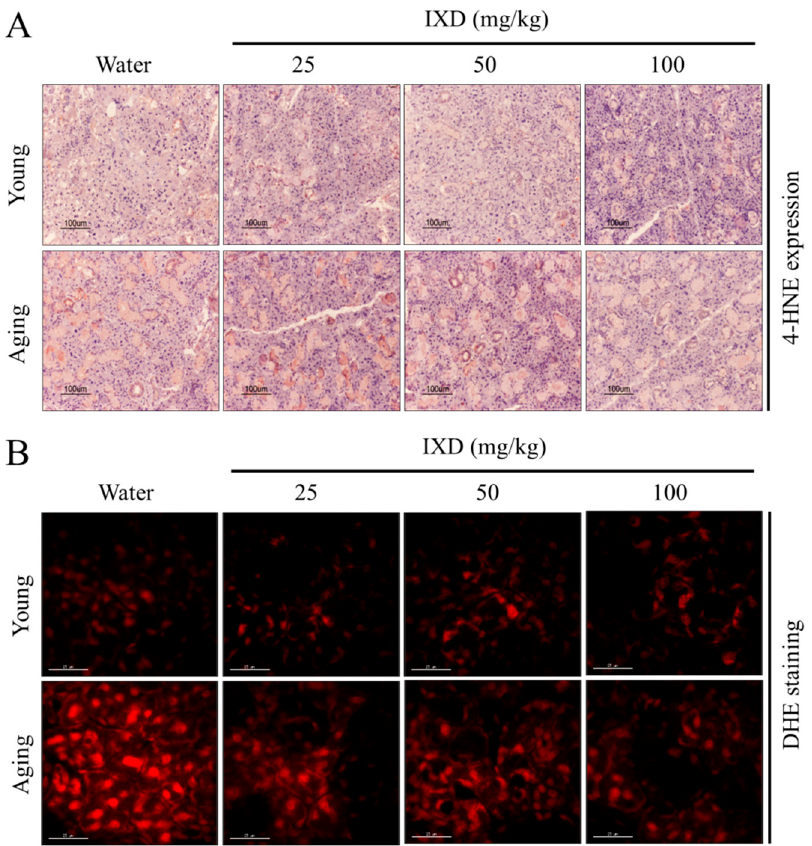
Figure 6. Aging-induced free radical generation was attenuated by IXD extracts. ( A ) Immunohistochemistry data revealing 4-HNE expression in the submandibular glands of the indicated groups. Magnification: 200×, Scale bar: 100 µm. ( B ) Dihydroethidium (DHE) fluorescent staining indicating reactive oxygen species (ROS) accumulation in the submandibular glands of the indicated rat groups. Pictures were taken using a tetramethylrhodamine isothiocyanate (TRITC) channel in confocal microscopy. Magnification: 600×, Scale bar: 25 µm.